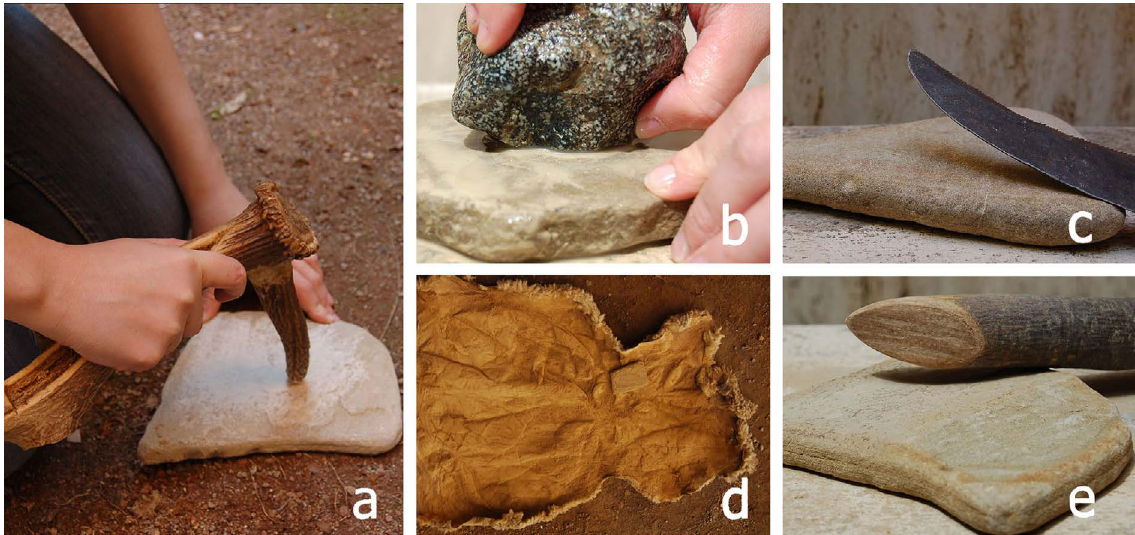
Figure 4. Experimental tests of abrasion: a. deer antler; b. stone; c. metal; d. hide; e.